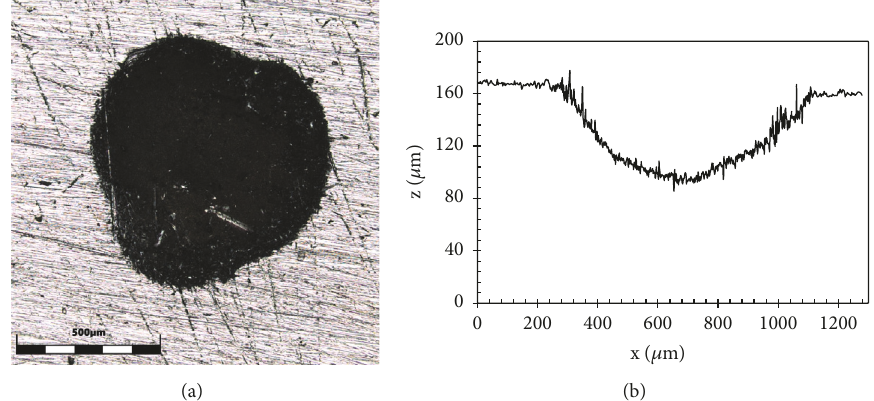
Figure 10: CLSM micrograph of a pit (a) and its corresponding transverse profile (b) for a representative N sample.